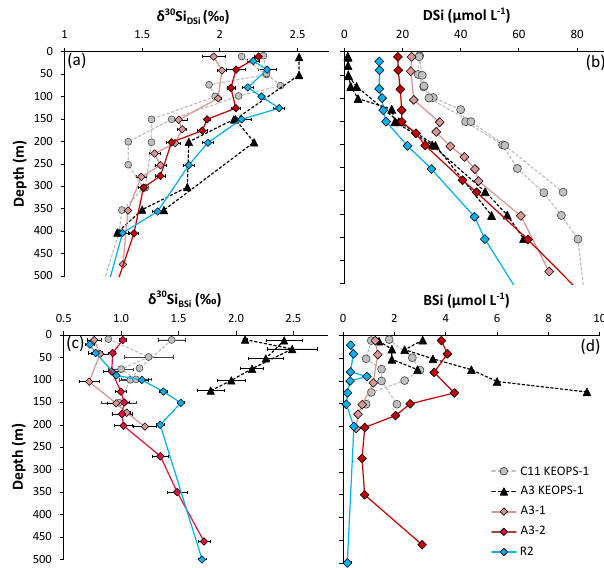
Figure 3. Seasonal evolution of the dissolved and particulate sili- con isotope composition ( a and c ) and concentration ( b and d ) in the upper 500m of the iron-fertilized (A3) and HNLC (C11 or R2) reference stations. Summer isotopic signatures (KEOPS-1, Fripiat et al., 2011a) are in grey and black colours; results from the spring period (this study) are in red and blue